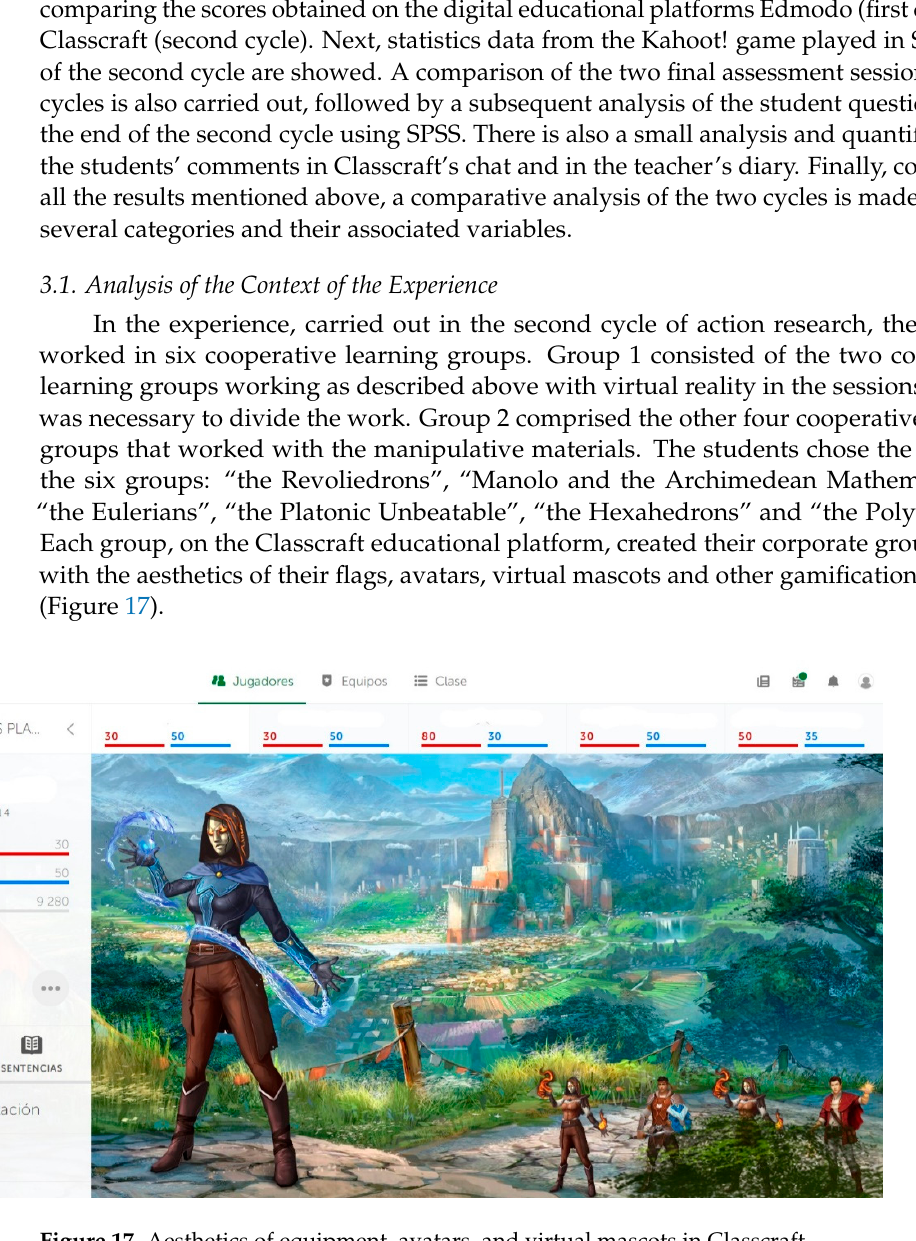
Figure 17. Aesthetics of equipment, avatars, and virtual mascots in Classcraft.